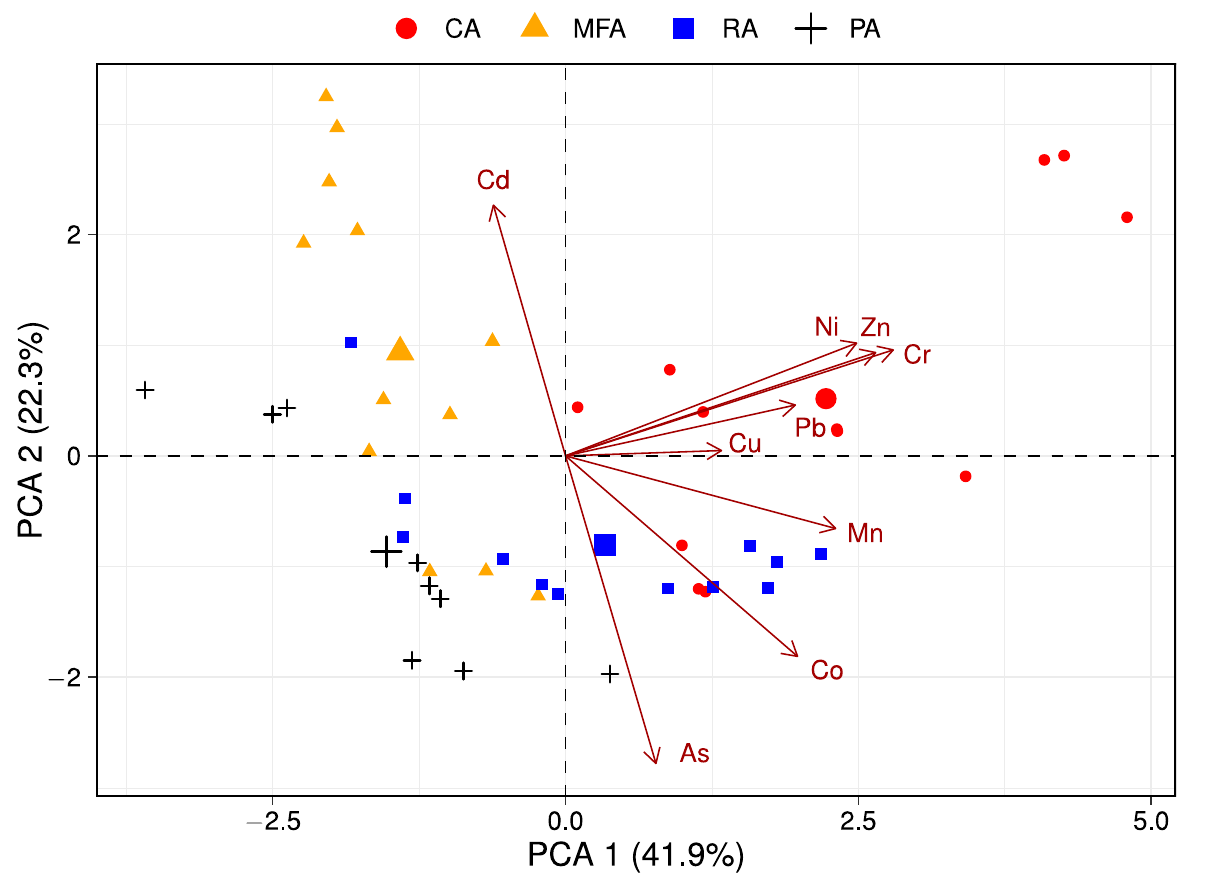
Figure 4. Principal component analysis (PCA) of toxic metal contamination of road dust in My- mensingh City based on land use types. CA = commercial areas, MFA = medically facilitated areas, RA = residential areas, PA = park areas.